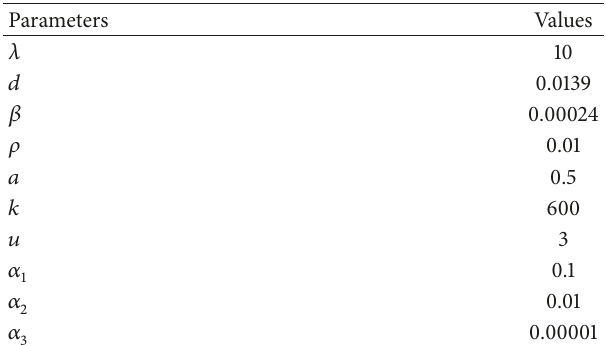
Table 1: Parameter values of system